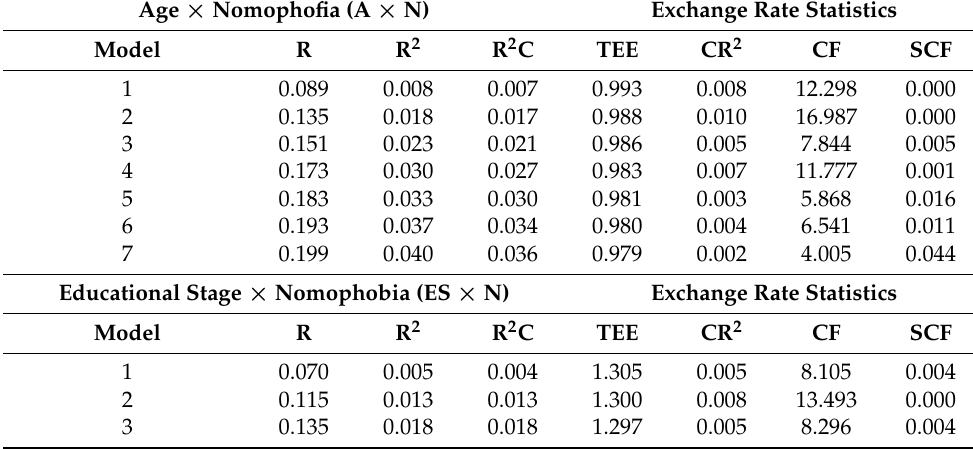
Table 3. Multiple-step regression